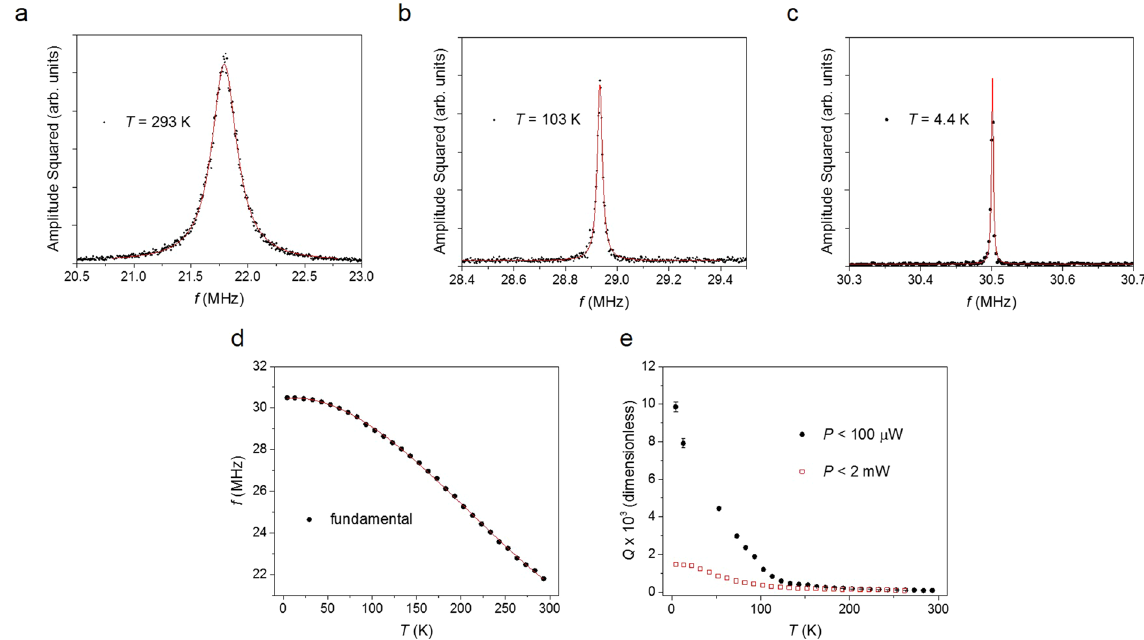
Figure 3. Temperature dependence of the MoS 2 resonator fundamental mode. ( a–c ) Square of the amplitude as a function of frequency, f , for varying temperature, T . The solid red lines are Lorentzian fits to the data. ( d ) Fundamental frequency as a function of T . The solid red line is a fit to a third-order polynomial, which is used in the subsequent data analysis for determining energy dissipation pathways. ( e ) Resonator quality factor, Q , as a function of T for varying laser power, P